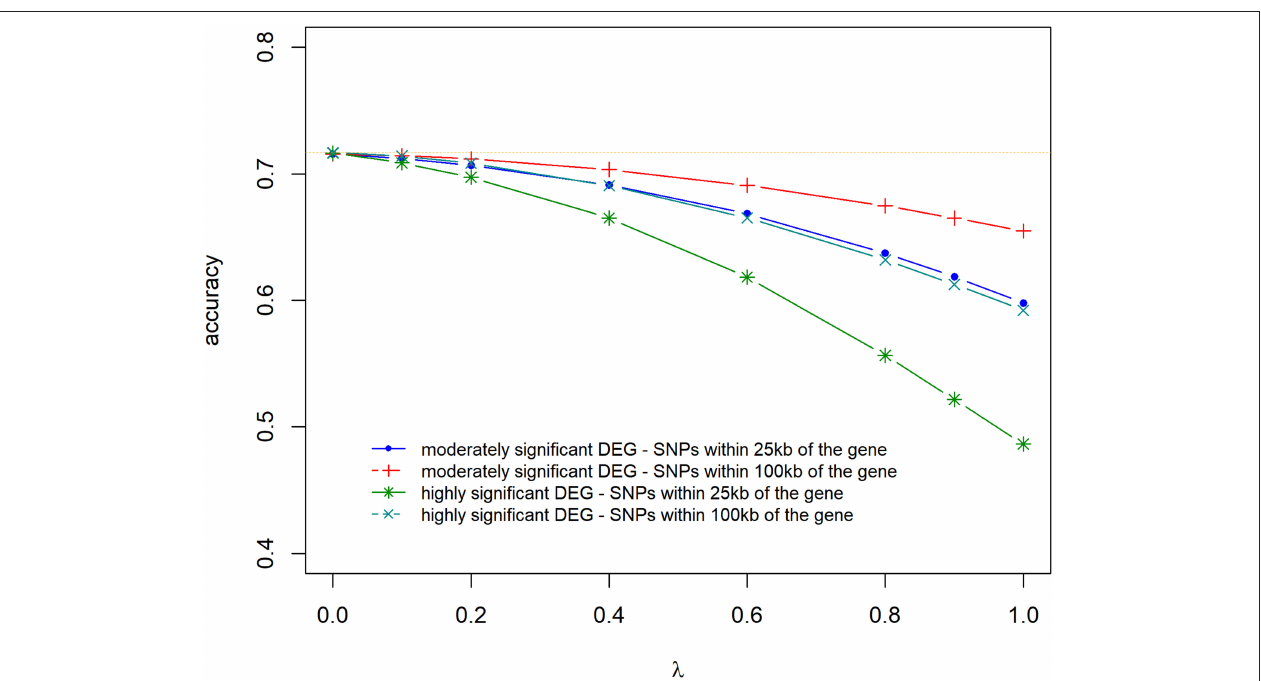
FIGURE 6 | Accuracy of selection of genomic predictions for different λ (blending of two genomic relationship matrices) values. The two genomic relationship matrices were generated for SNPs that were either within significant genes in gene expression analysis or not. Markers within significant DE genes were also weighted with the log 2 1 F of that